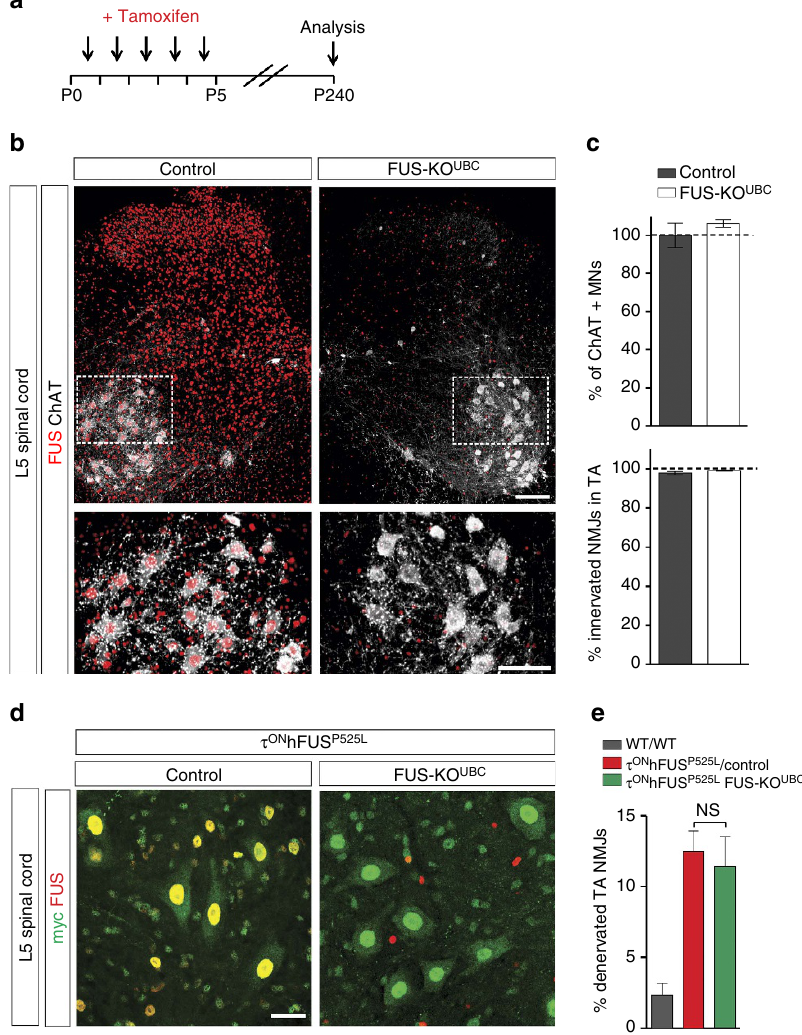
Figure 7 | Widespread postnatal deletion of FUS does not cause MN degeneration. ( a ) Experimental paradigm for early postnatal induction of CreERT2 activity. Mice were treated with tamoxifen at postnatal days 1–5 and were analysed at p240. ( b ) L5 spinal cords of p240 control (FUS FLOX/ WT ; UBC- CreERT2 þ / (cid:2) , left) and FUS-KO UBC (FUS FLOX/ KO ; UBC-CreERT2 þ / (cid:2) , right) animals immunostained for FUS (red) and ChAT (white). Outlined areas of top panels are reproduced at higher magnification in the bottom panels. Loss of FUS immunoreactivity was observed in 96.0 ± 3.8% of NeuN-IR neurons and 83.0 ± 4.8% of NeuN-negative cells. N ¼ 3. Scale bar, 200 m m (top), 50 m m (bottom). ( c ) The numbers of MNs in the L5 spinal cord normalized to control (top) and the percentage of innervated NMJs in the tibialis anterior (TA) muscle (bottom) in p240 control (dark grey) and FUS-KO UBC (white) animals. N ¼ 3. ( d ) Representative images of L5 MNs in t ON hFUS P525L /control (left) and t ON hFUS P525L /FUS-KO UBC animals (right). ( e ) Percentage of denervated NMJ’s in the TA muscle of t ON hFUS P525L /control (red) and t ON hFUS P525L /FUS-KO UBC (green) animals ( N ¼ 4 for all groups. For d and e , the genotypes of the t ON hFUS P525L /control and the t ON hFUS P525L /FUS-KO UBC animals were t ON hFUS P525L ;FUS FLOX/ WT ;UBC-CreERT2 þ / (cid:2) and t ON hFUS P525L ;FUS FLOX/ KO ;UBC-CreERT2 þ / (cid:2) ,